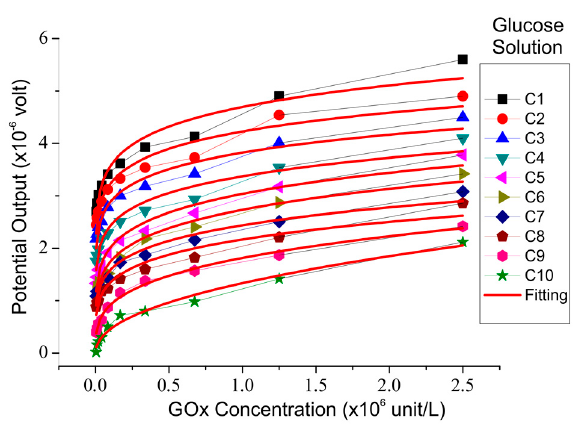
Figure 5. Sensor output voltage compared to glucose concentrations for various enzyme concentrations.